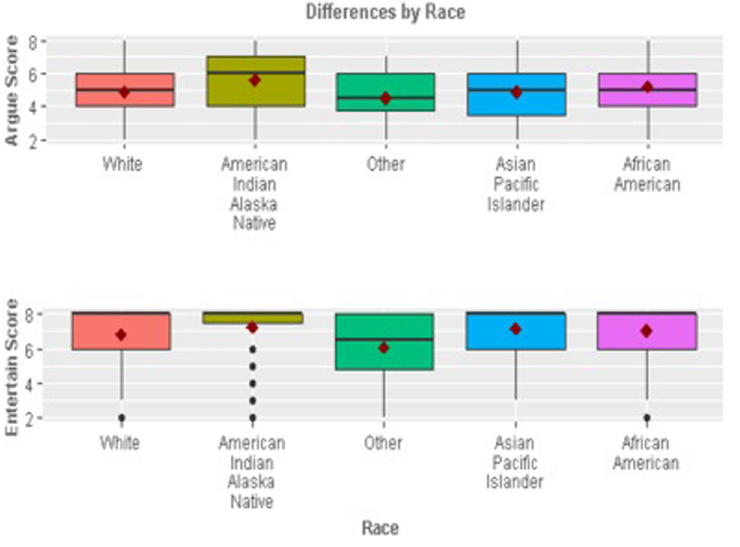
Fig 4. Significant differences by